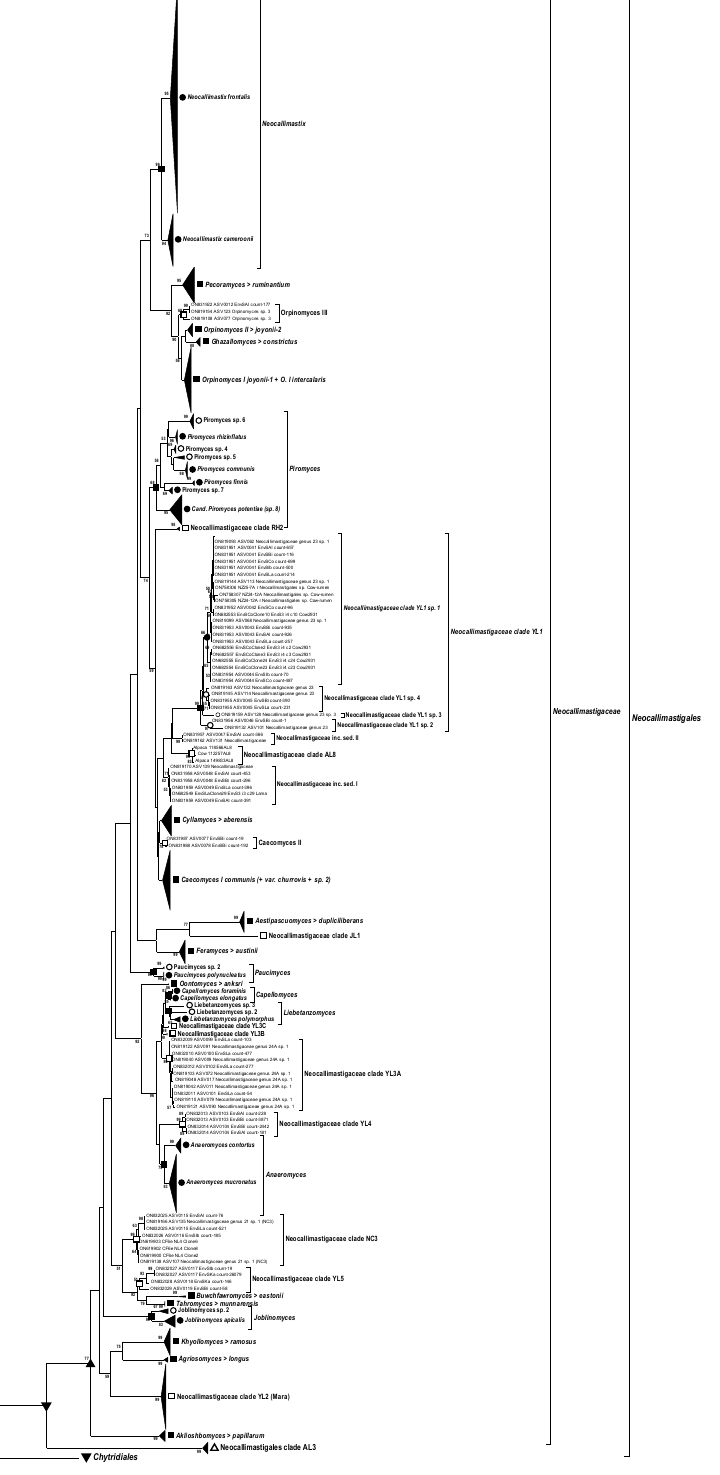
Figure 7. Partly compressed phylogenetic tree with the AGF-LSU-EnvS (D2 LSU) amplicons of the current study. DQ536493 ( Chytriomyces sp. WB235A) was used as an outgroup. Clades with strong representation by Sanger and Illumina sequences are compressed, and novel clades (except for the Neocallimastigaceae clade YL2 “Mara clade”) are resolved. Accession numbers ON819131–ON819177 are from [25]. The expanded phylogenetic tree is added as Supplementary Data